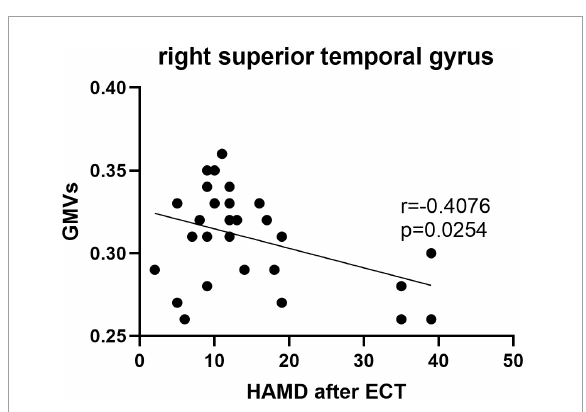
FIGURE6 Negative correlations between the HAMD after ECT and GMVs in the right superior temporal gyrus ( r = –0.4076, p = 0.0254).